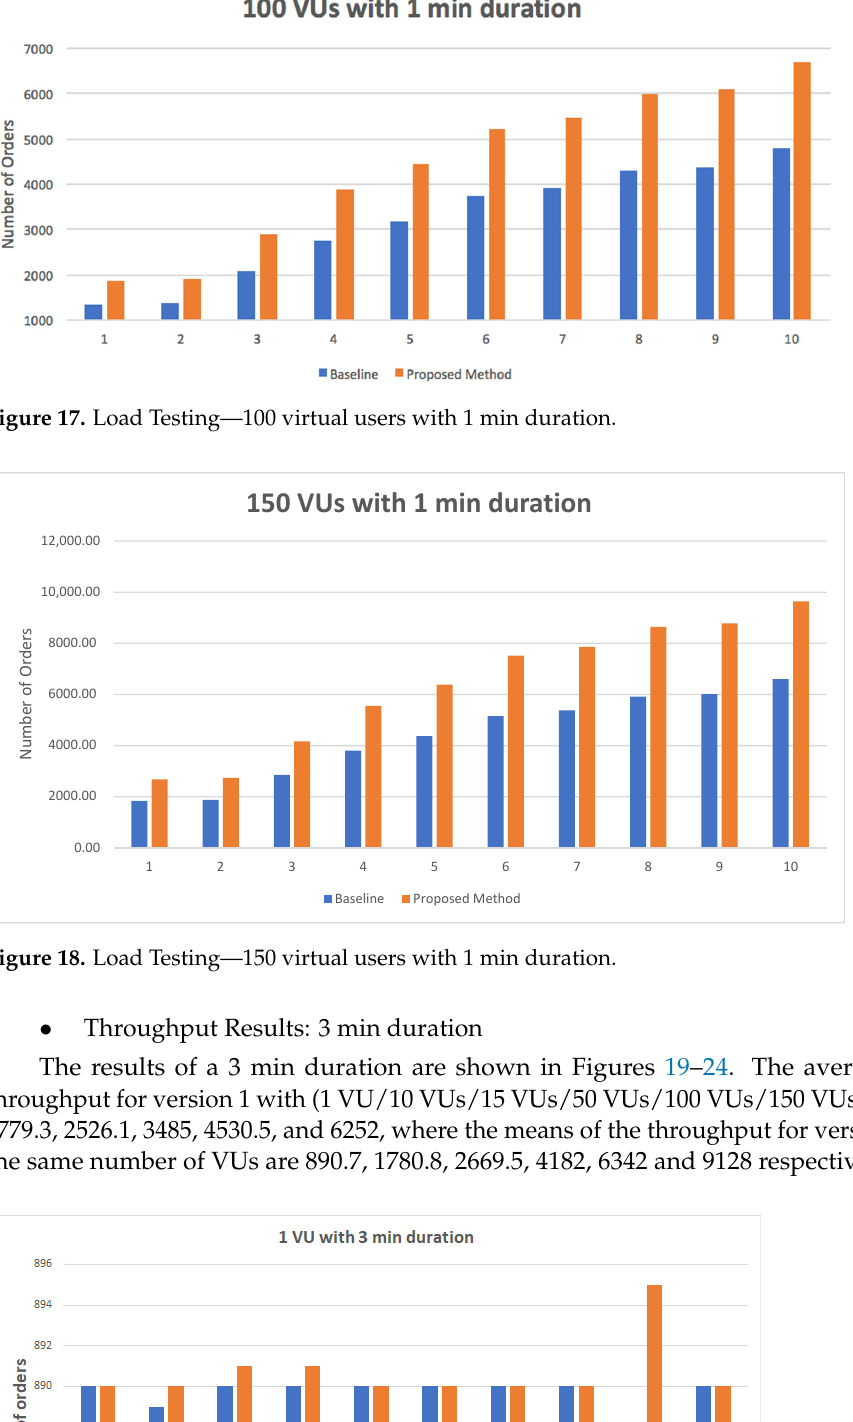
Figure 16. Load Testing—50 virtual users with 1 min duration.